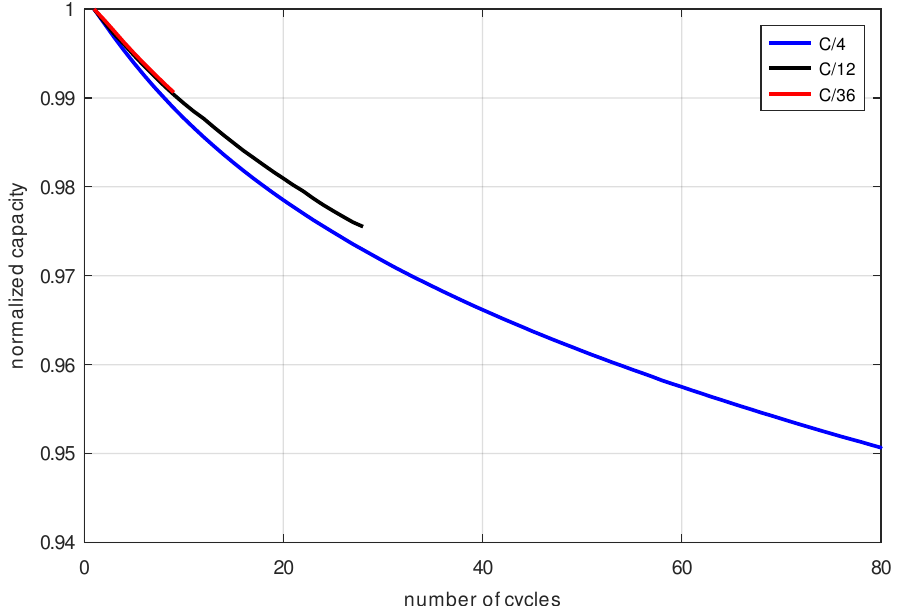
Figure 12. Normalized capacity decrease observed over the number of cycles. For this purpose, an LG INR18650 MJ1 cell was cycled with C/4, C/12 and C/36 at 40 °C ambient